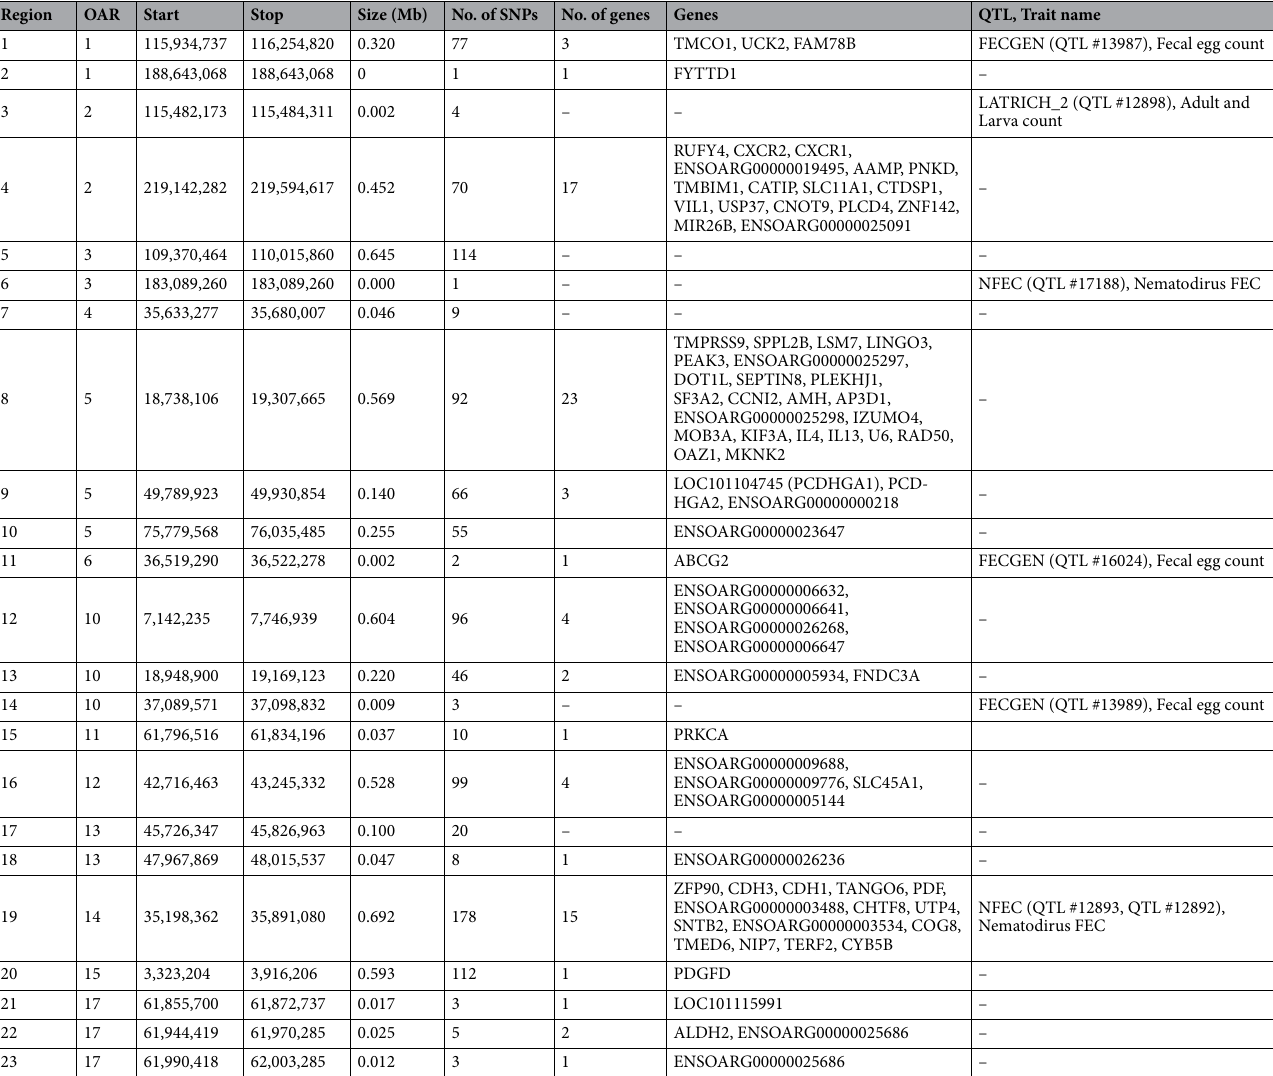
Table 3. Candidate regions that are specific to the non-infected cohort as identified by ROH